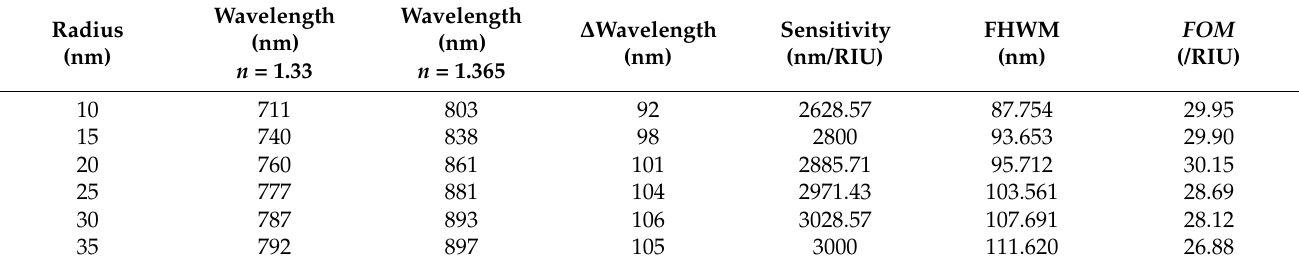
Table 3. Evaluation of the sensing performance for the different radii of the SiO 2 nanorods.